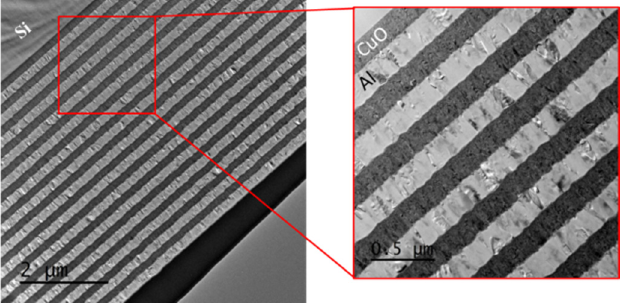
Figure 1. Cross-sectional transmission electron micrographs of the Al/CuO multilayer obtained by magnetron sputtering.